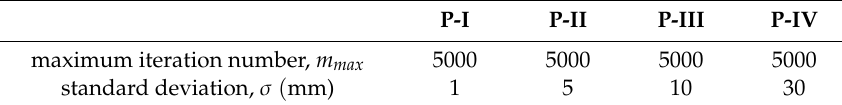
Table 4. Di ff erent settings of local search